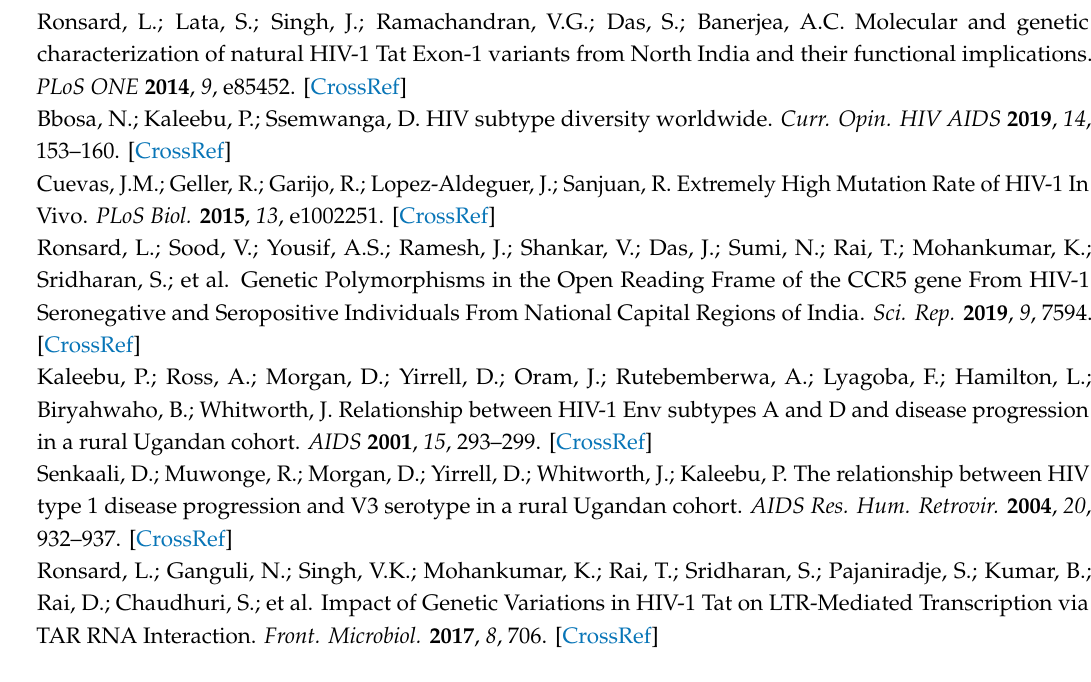
Figure S1: pSIREN-RetroQ-ZsGreen1 vector. Figure S2: Tat subtypes and variants induced cell death in TZM-bl cells. Figure S3: Tat subtypes induce cell death via release of cytochrome-c. Figure S4: the e ff ect of Tat on GFP-driven expression. Figure S5: The cell death and RSS activity normalized with the protein expression of corresponding Tat subtypes and